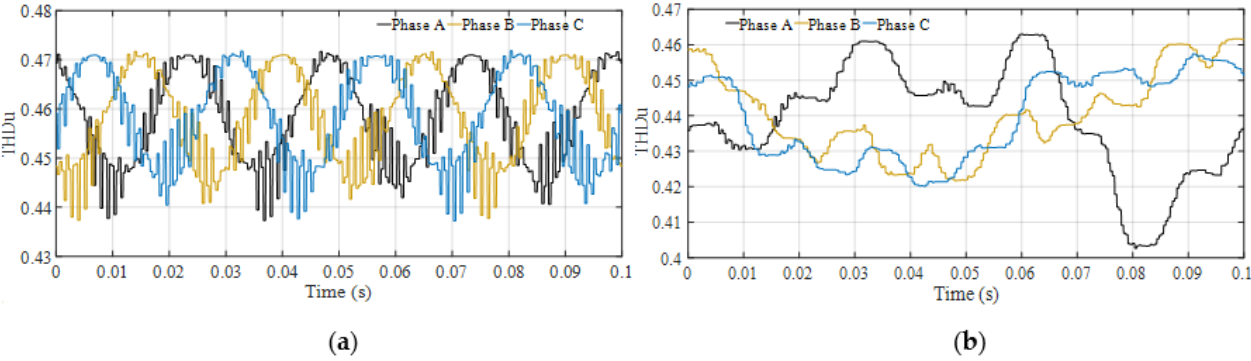
Figure 30. Total harmonic distortion of the voltage (THDu). ( a ) Deformed by harmonic and ( b ) operating EVs as active